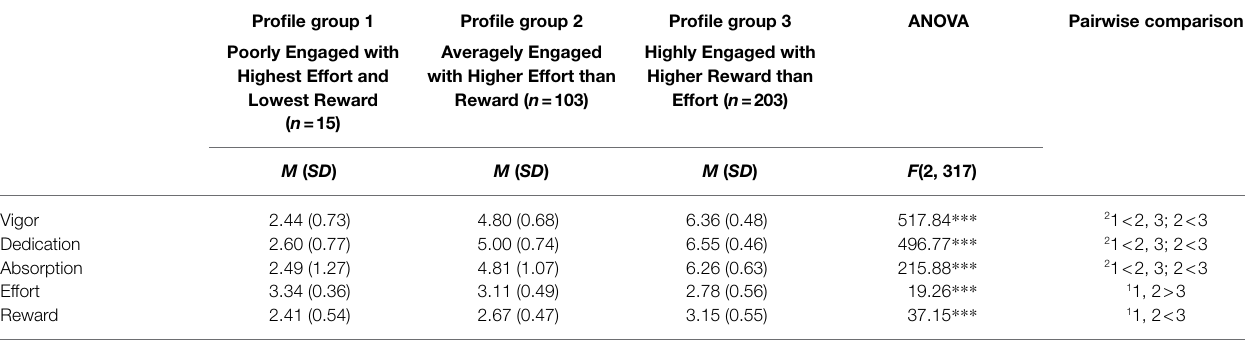
TABLE 3 | Differences in work engagement and work-related effort and reward among profile groups. Profile group